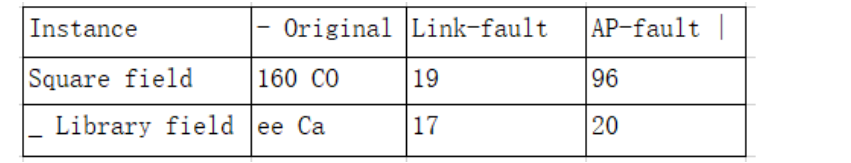
Figure 21. Excel output for scanned table image 3 by our algorithm.